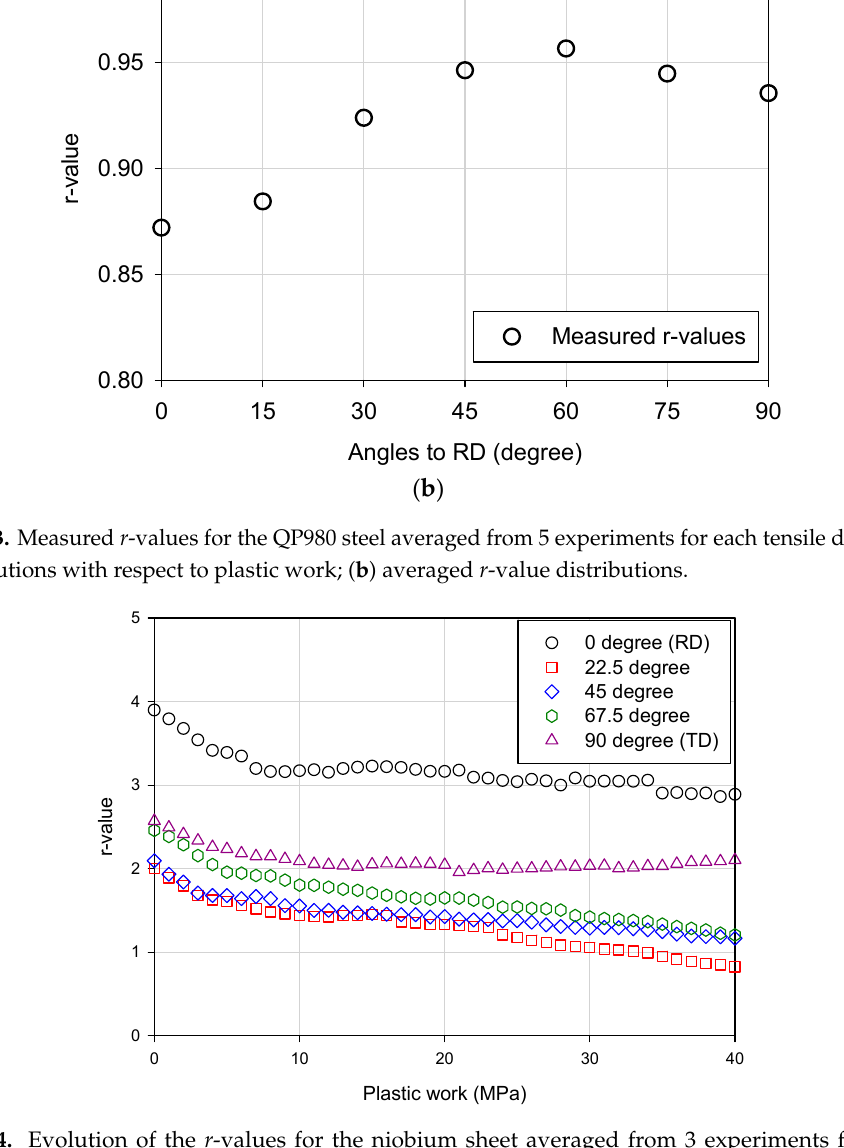
Figure 4. Evolution of the r -values for the niobium sheet averaged from 3 experiments for each tensile direction.